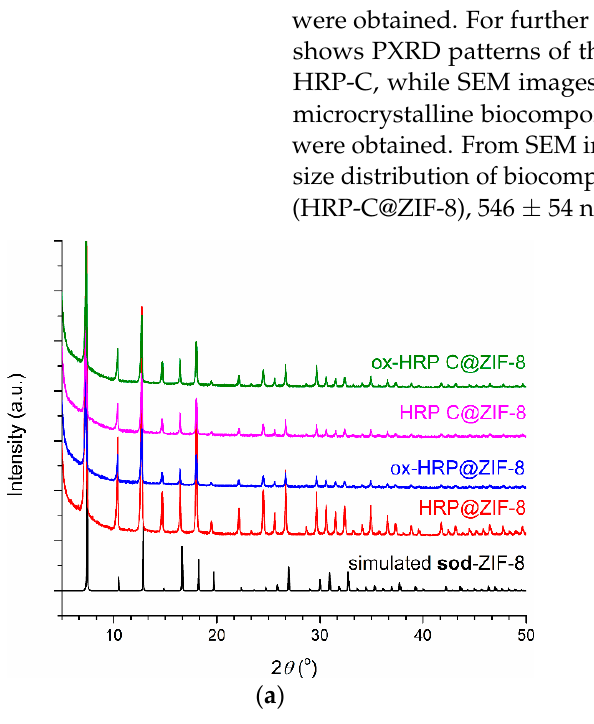
Figure 3. ( a ) Simulated PXRD pattern of the sod ‐ ZIF ‐ 8 and experimental PXRD patterns of the enzyme@ZIF ‐ 8 samples obtained during 30 min, washed with distilled water and air dried; ( b ) SEM images of four types of biocomposites (scale bar 500 nm).